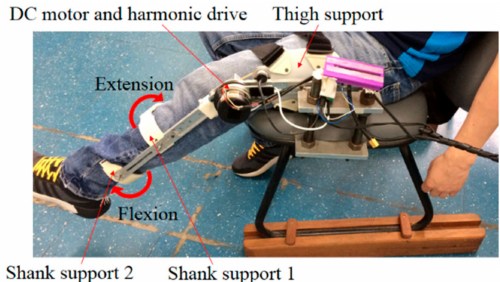
Figure 4. Exoskeleton for knee rehabilitation exercises with the 3D-printed flexible supports positioned on the shank